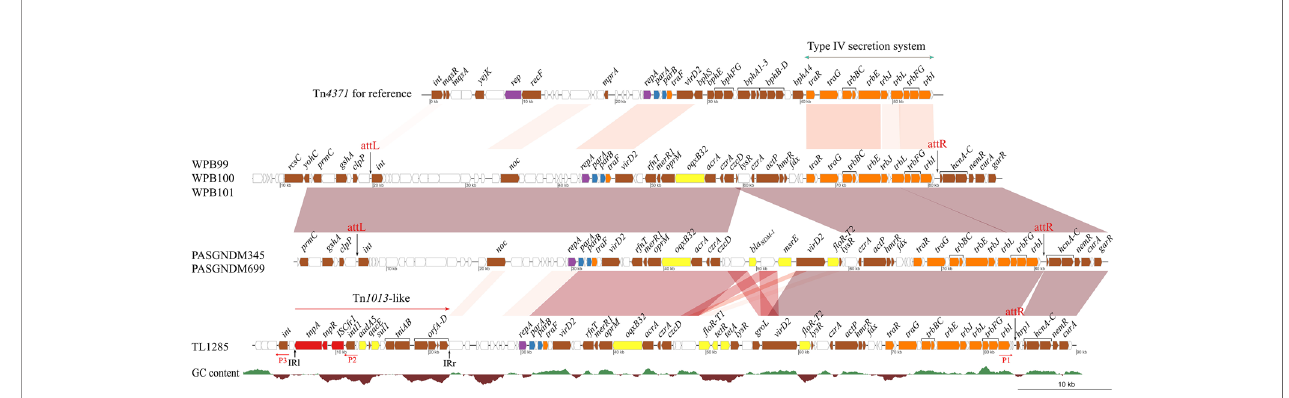
FIGURE 5 | Comparative genomic analysis of the ICE region of TL1285 and 5 other fl oR-T2 -carrying P. aeruginosa isolates. Genes with different functions are shown in different colors: red, transposable elements; yellow, drug resistance; orange, conjugational transfer; blue, plasmid maintenance; purple, replication; brown, genes with other functions; white, hypothetical